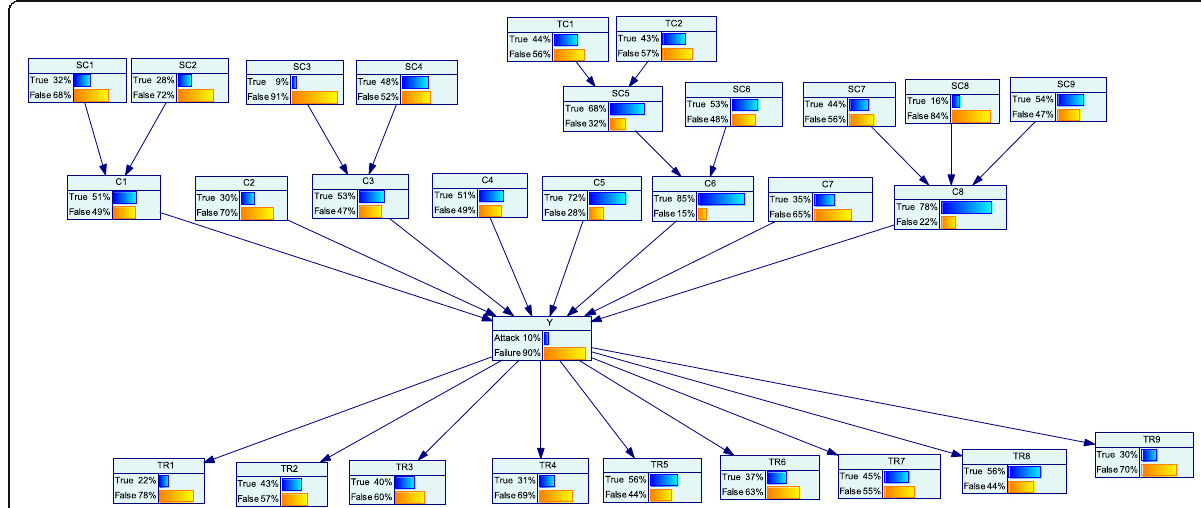
Fig. 7 Constructed BN Model – No Evidence Provided. (In this figure, SC 1: Easy physical access to sensor, SC 2: Easy physical access to communication cable, C 1: Easy physical accessibility, C 2: No sensor data integrity verification, SC 3: Sensor is connected to WIFI, SC 4: ICS and corporate networks are interconnected, C 3: Easy network accessibility, C 4: Presence of software in sensor, C 5: No sensor firmware update, TC 1: Lack of maintenance of sensor, TC 2: Lack of maintenance of communication cable, SC 5: Lack of maintenance, SC 6: Poor maintenance process, C 6: Maintenance issue, C 7: No use of EMI shielding technique, SC 7: Location of sensor susceptible to severe weather, SC 8: Location of sensor susceptible to physical contact of marine vessel, SC 9: Location of sensor susceptible to biological fouling, C 8: Location of sensor susceptible to external factor, Y : Major cause for sensor sends incorrect water level measurements, TR 1: Test/redundant sensor also sends incorrect water level measurements, TR 2: Sudden change of water level measurements from sensor, TR 3: Suspicious traffic in ICS network, TR 4: Abnormalities in other components, TR5: No power in sensor, TR 6: Communication cable deteriorated, TR 7: Sensor sends correct water level measurements after cleaning sensor, TR 8: Sensor sends correct water level measurements after recalibrating sensor, TR 9: EMI along